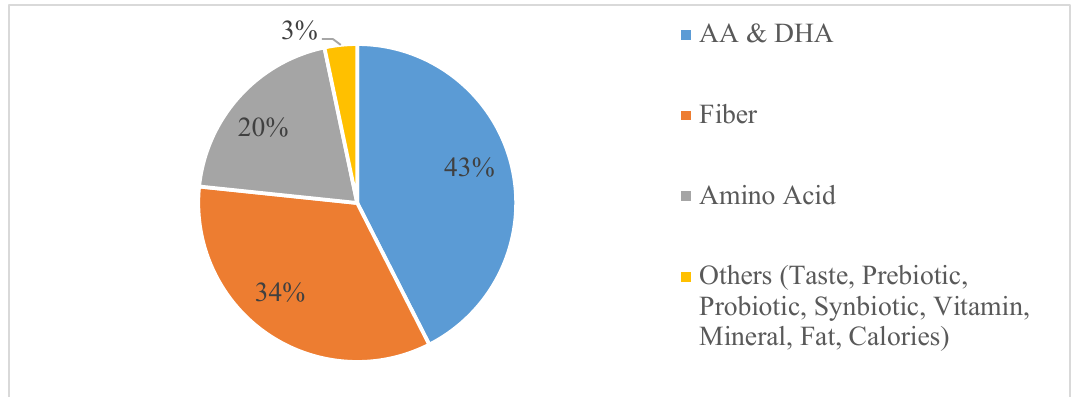
Figure 3. Perspective on specific ingredients that should be added in soy milk Table 3. Perspective on fibre adequacy in children who couldn’t drink cow’s milk among healthcare professionals and its relationship